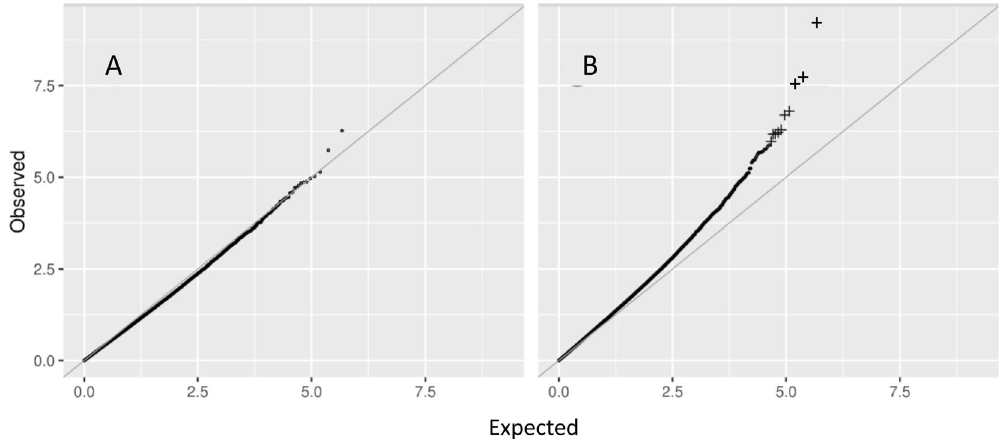
Figure 1. QQ plot of differential methylation sites subjected to crude analysis ( A ) and in analysis adjusted with fixed batch effects, smoking, and cell composition ( B ). Significant sites after FDR-adjustment is marked by +